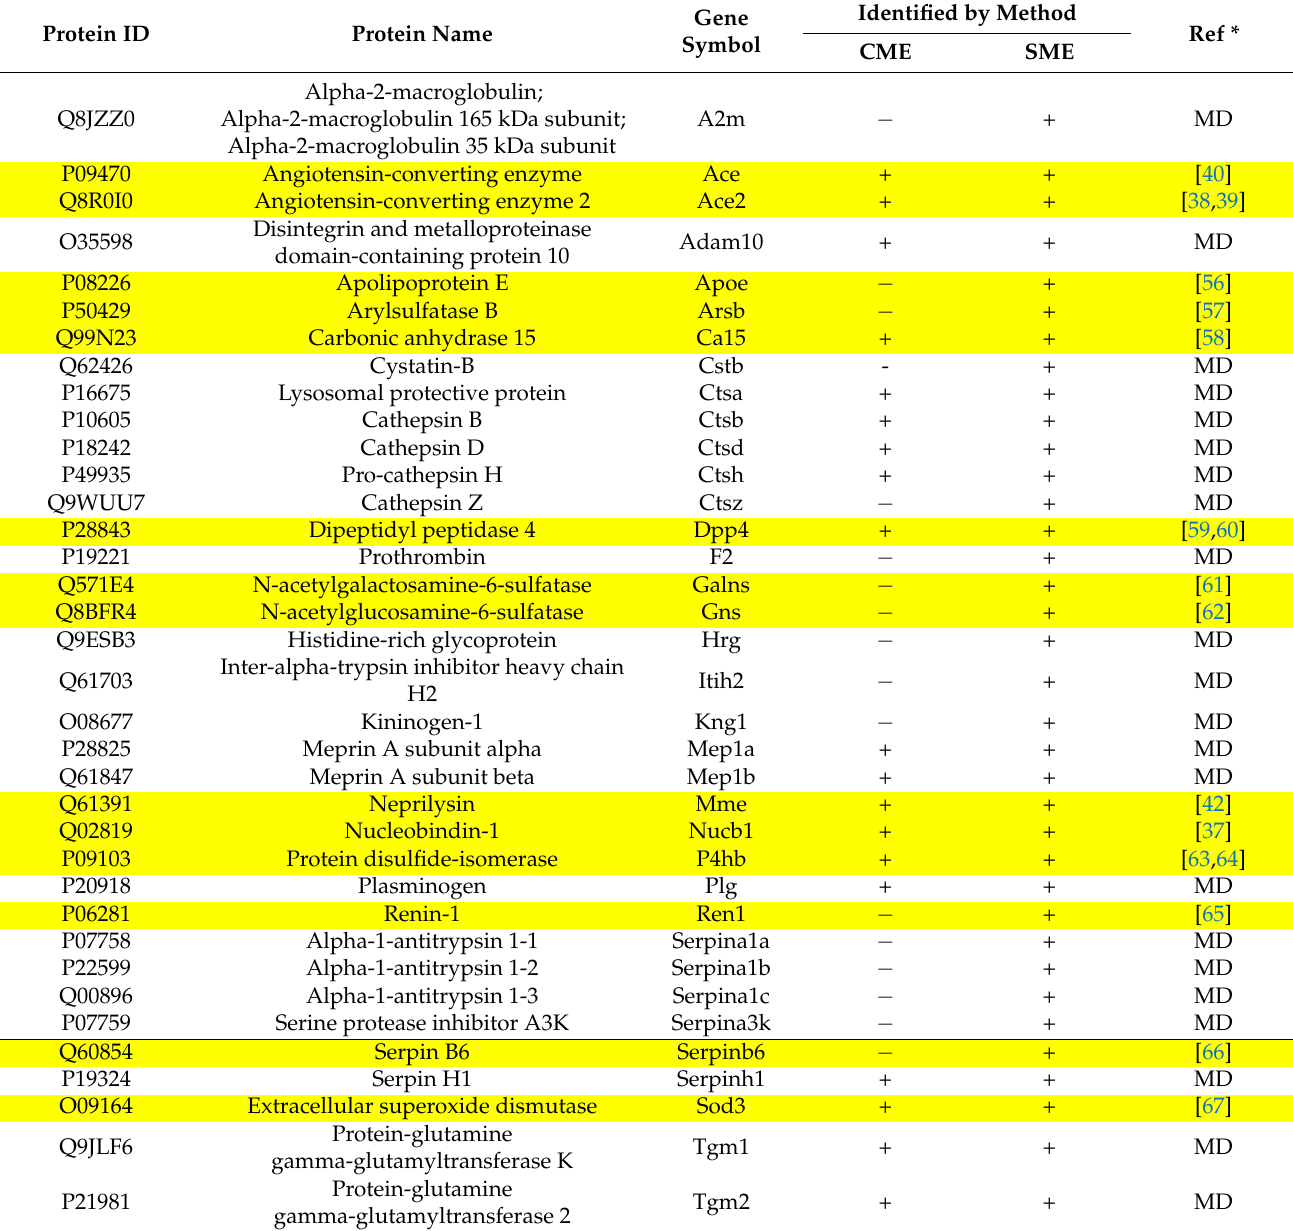
Table A4. The list of matrisome-associated proteins belonging to the category of ECM regulators and identified in at least two of the biological replicates. Rows highlighted in yellow describe identified matrisome proteins which were not previously listed in the